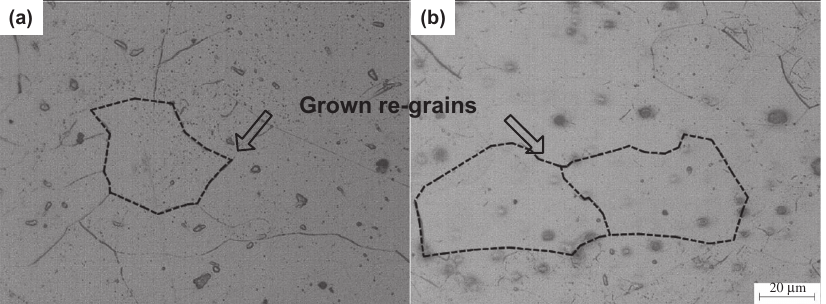
Figure 8: Microstructure evolution under the temperature of 1,030°C and the strain rates of (a) 0.01 s − 1 and (b) 0.001 s − 1